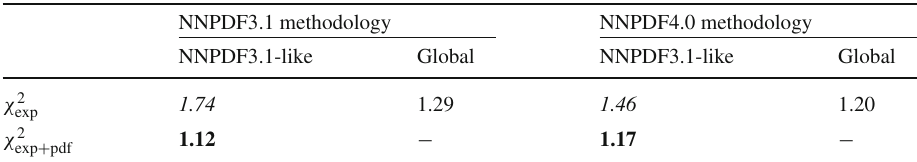
Table 29 Same as Table 28, now for the